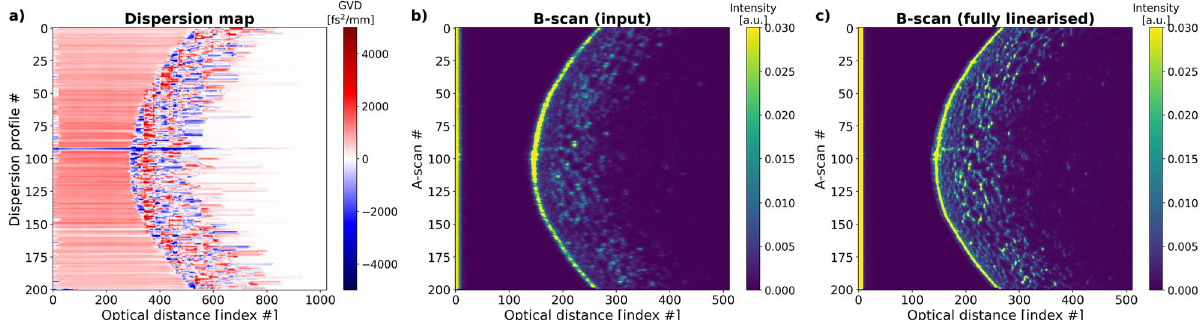
Figure 7. ( a ) Dispersion map of the grape, ( b ) the B-scan where the dispersion imbalance in the interferometer is not compensated. ( c ) An image for which the unbalanced dispersion was compensated. The twice bigger length of the x axis in the dispersion maps is a by-product of the FFT stack generation.